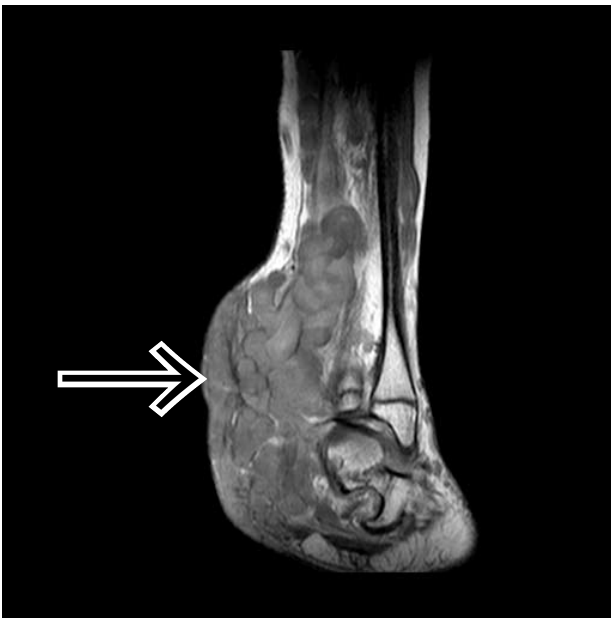
Fig. 5a. Coronal T1-weighted image of the distal lower limb showing poorly delineated multiple tortuous worm-like masses typical of a plexiform neurofi- broma (courtesy of Dr Z Ebrahim).